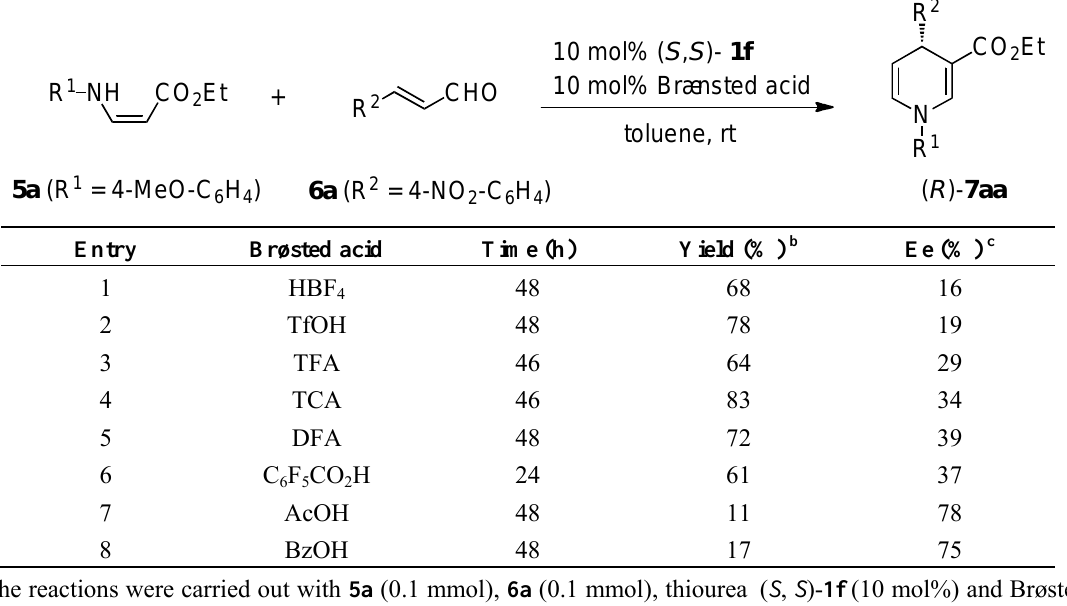
NR 2 CO Et 2 R 1 ( R )- 7aa